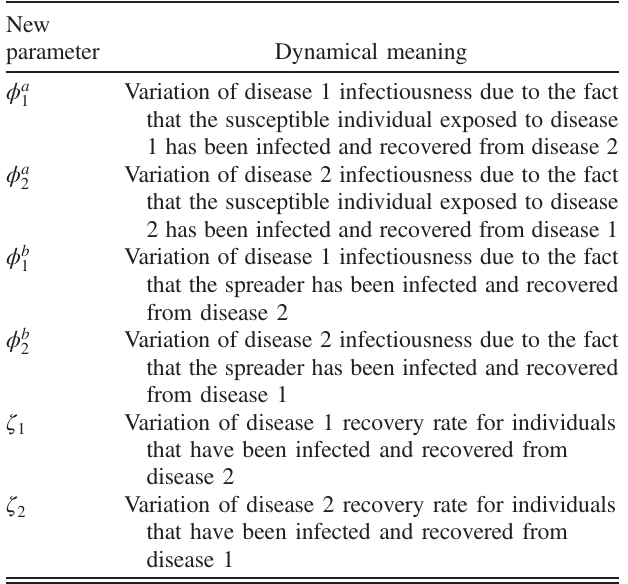
TABLE III. Parameters describing the influence of R classes on the conjugate